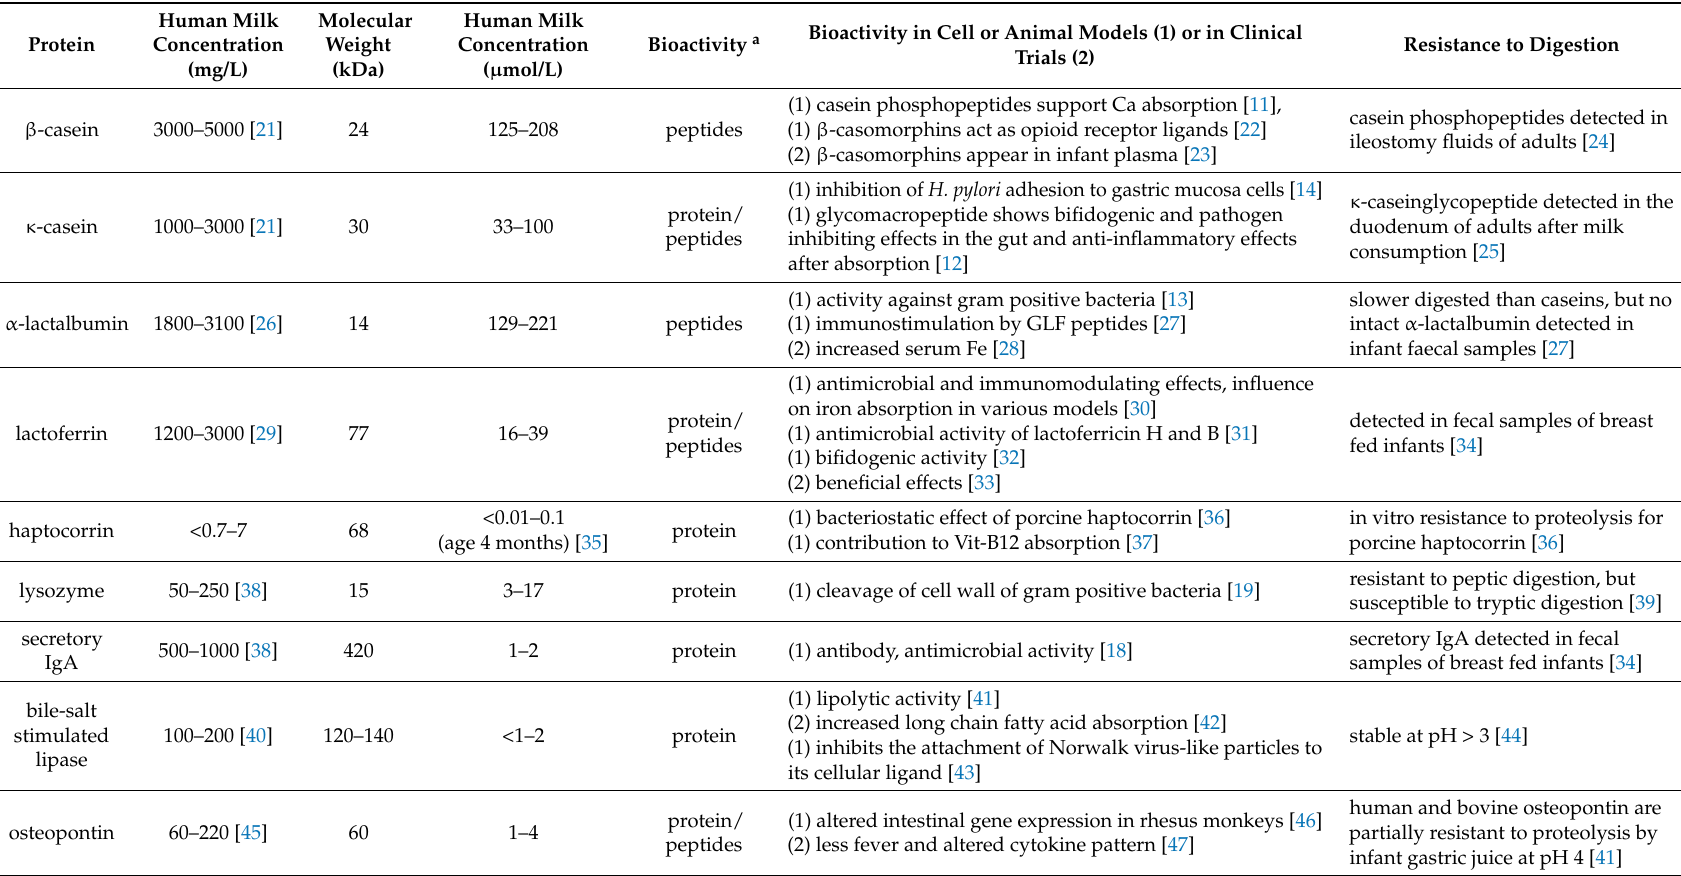
Table 1. Overview of proteins and peptides in mature human milk with presumed functions or activities in addition to being a source of amino acids to breast fed